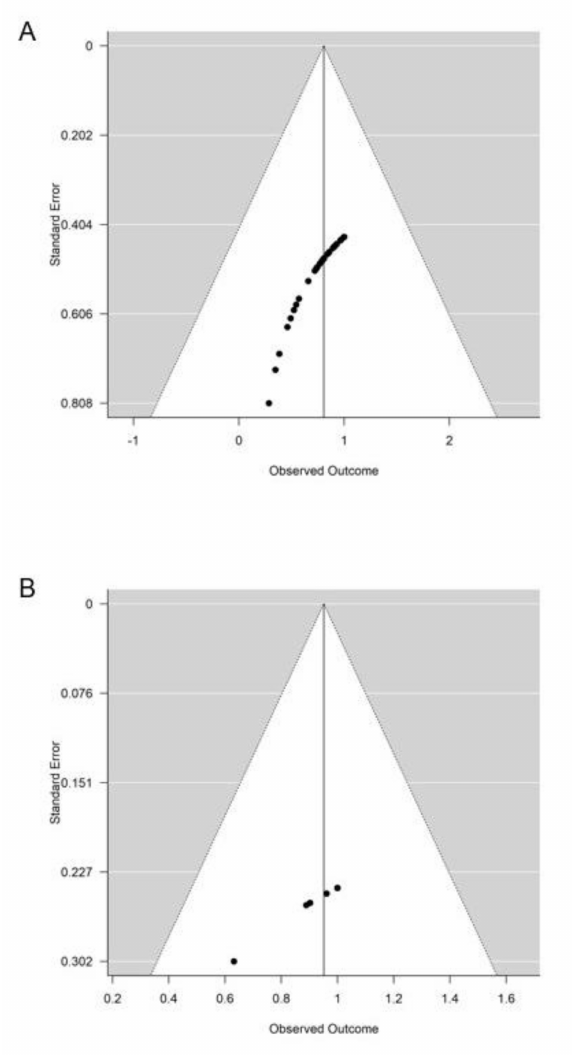
Figure 5. Analysis of publication bias. Funnel plots were drawn for EA ( A ) and SA ( B ) indicating no evidence of publication bias. Funnel plots were not used for PD as less than 10 PD papers were included in the meta-analysis. EA: endoscopic ampullectomy, SA: surgical ampullectomy, PD: